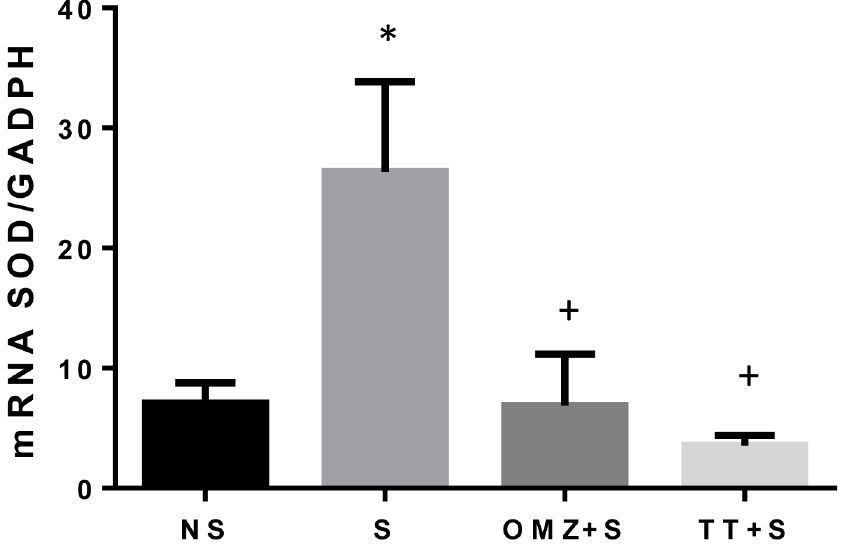
Fig 3. Effects of tocotrienol (60 mg/kg BW) (TT) or omeprazole (20 mg/kg BW) (OMZ) on gastric SOD mRNA expression in rats exposed to water immersion restraint stress (n = 7). * vs non-stressed control (NS) (P < 0.05). + vs stressed control (S) (P < 0.05).